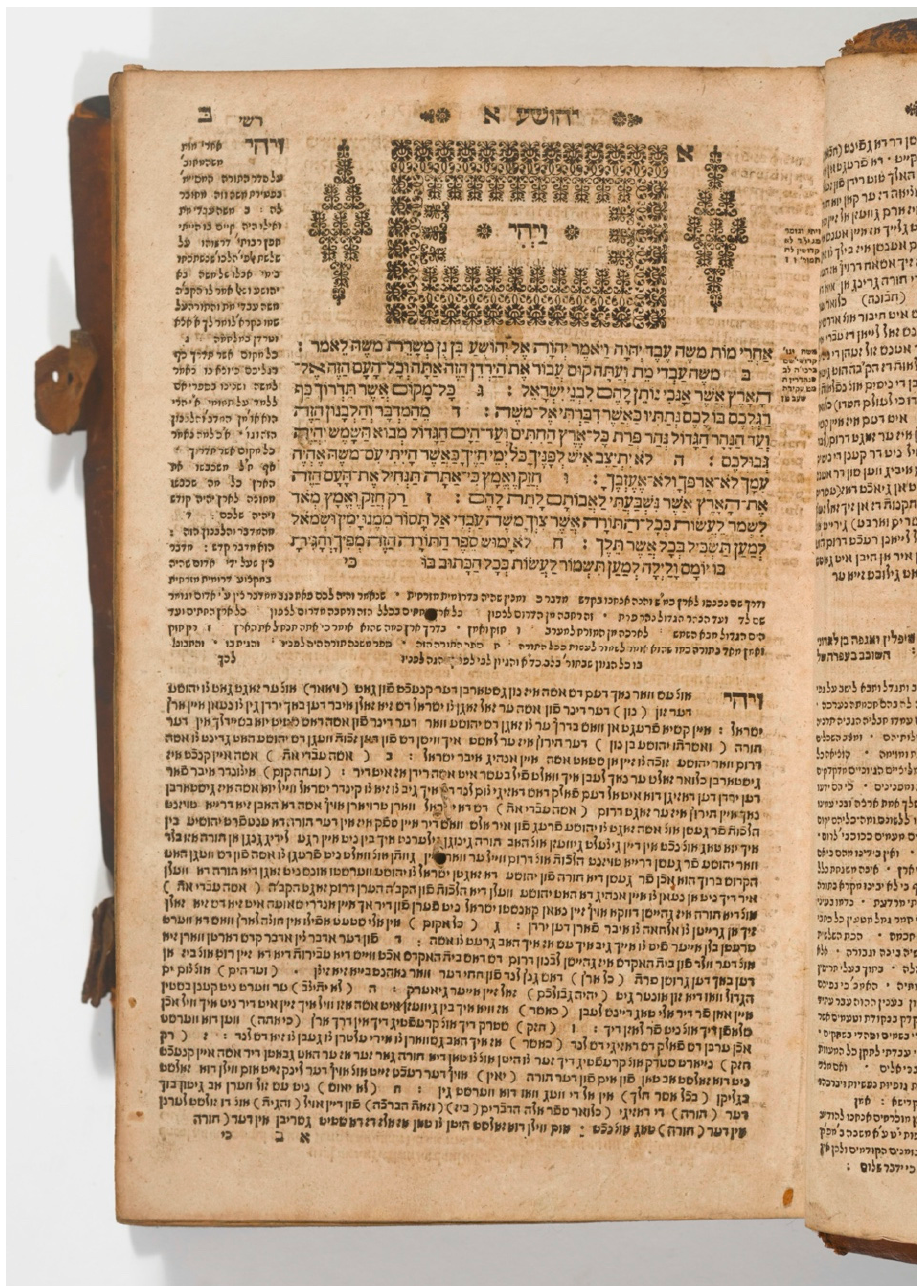
Figure 22. Sefer HaMagid, Marsh’s Library C.3.1.19.